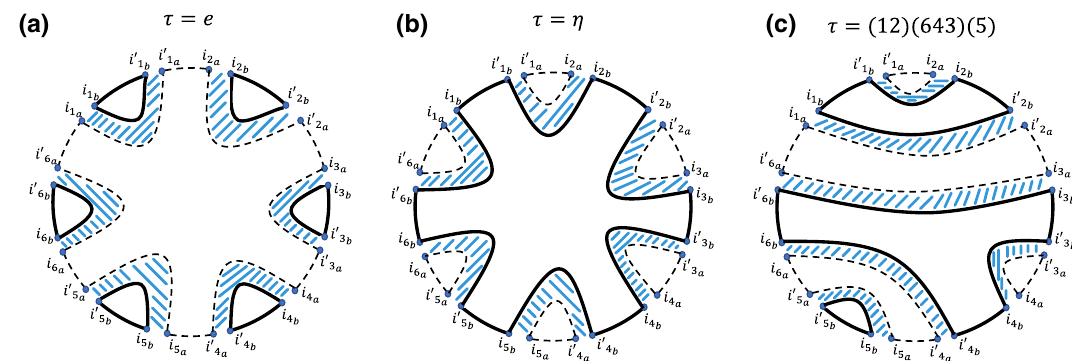
FIG. 3. Examples of planar diagrams corresponding to different choices of planar permutations τ that saturate Eq. (48).